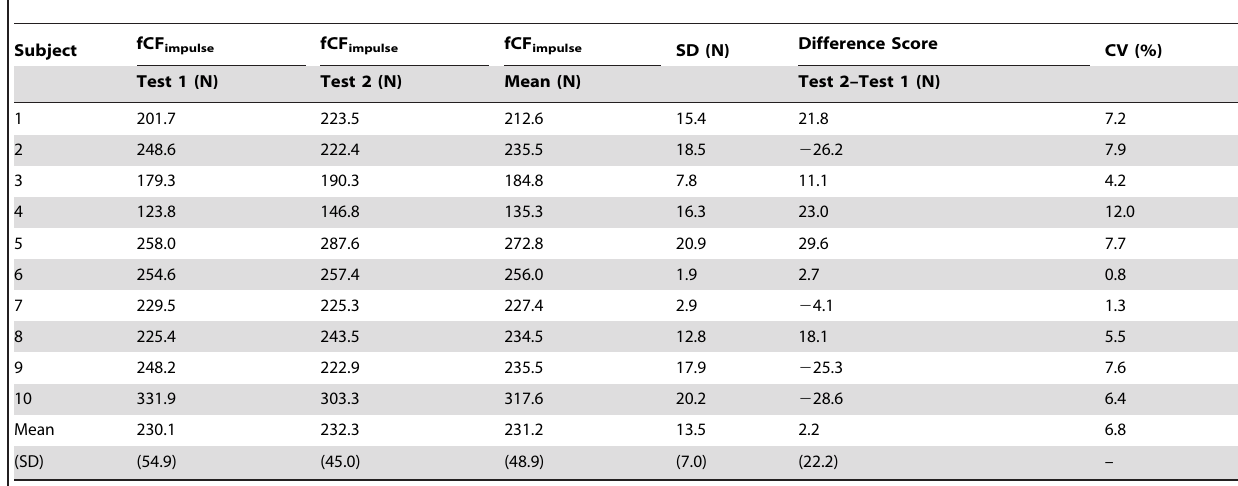
Table 2. Forearm critical intensity impulse (fCF impulse ) and its test-retest